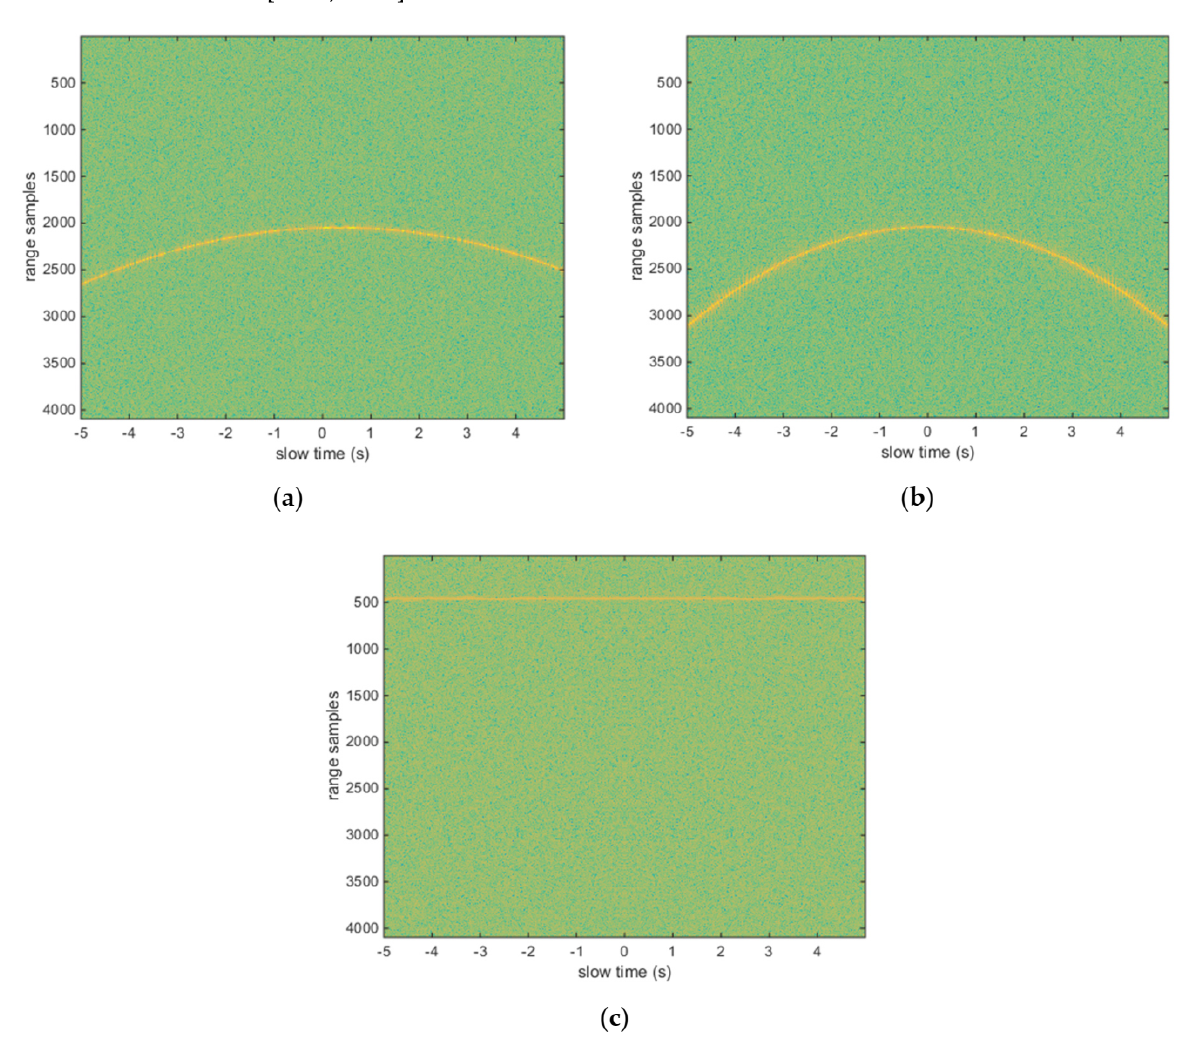
Figure 4. SKT processing results before and after the pre-compensation operation. ( a ) The original echo; ( b ) SKT processing results before the pre-compensation operation; ( c ) SKT processing results after the pre-compensation